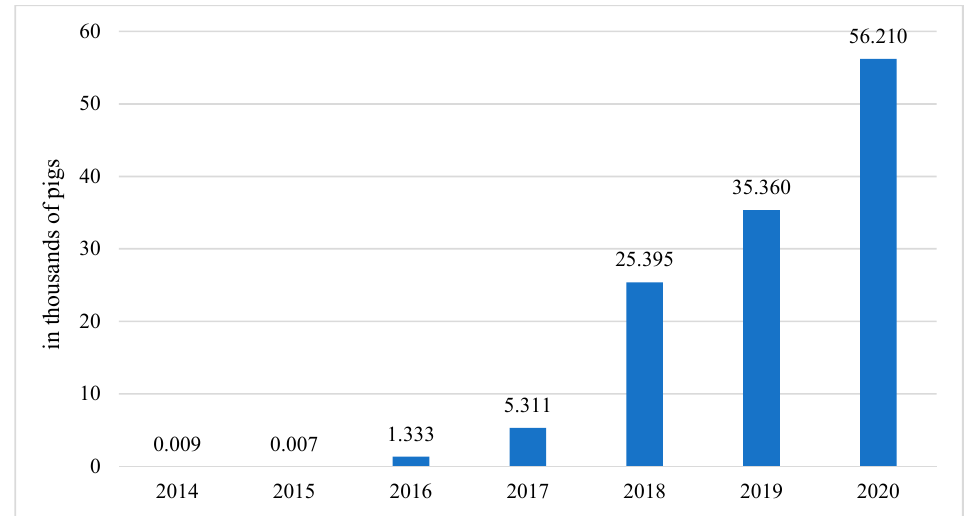
Figure 4. The number of pigs in ASF outbreaks in Poland. Source: Chief Veterinary Inspectorate. The occurrence of ASF outbreaks in domestic swine concerns both small and large scale farms. The fact is that the production of live pigs in Poland is very fragmented. Many farms are characterised by a small scale of production. The structure of pig farms is dominated by farms with a production scale of up to 50 pigs, whose share is about 75.1%. On the other hand, the share of farms with over 1000 pigs is only 2.0%. Due to this structure of pig farms, the largest number of ASF outbreaks in domestic pigs was recorded within the group of farms ranging from 10 to 49 pigs (41.75%) (Table 2). A smaller percentage of ASF outbreaks in domestic pigs concerns holdings with up to 9 pigs (27.9%). In the group of entities keeping from 50 to 99 pigs, ASF outbreaks in domestic pigs occurred in every 10 farms. A similar situation was observed in farms with 100 to 399 pigs where ASF outbreaks in domestic pigs occurred in 8.6% of farms. On the other hand, in farms with 499 to 1000 pigs, the outbreaks were recorded in 4.1% of farms, and in farms with herds of over 1000 pigs their share was 7.7%. Table 2. Structure of outbreaks according to the pig rearing scale in